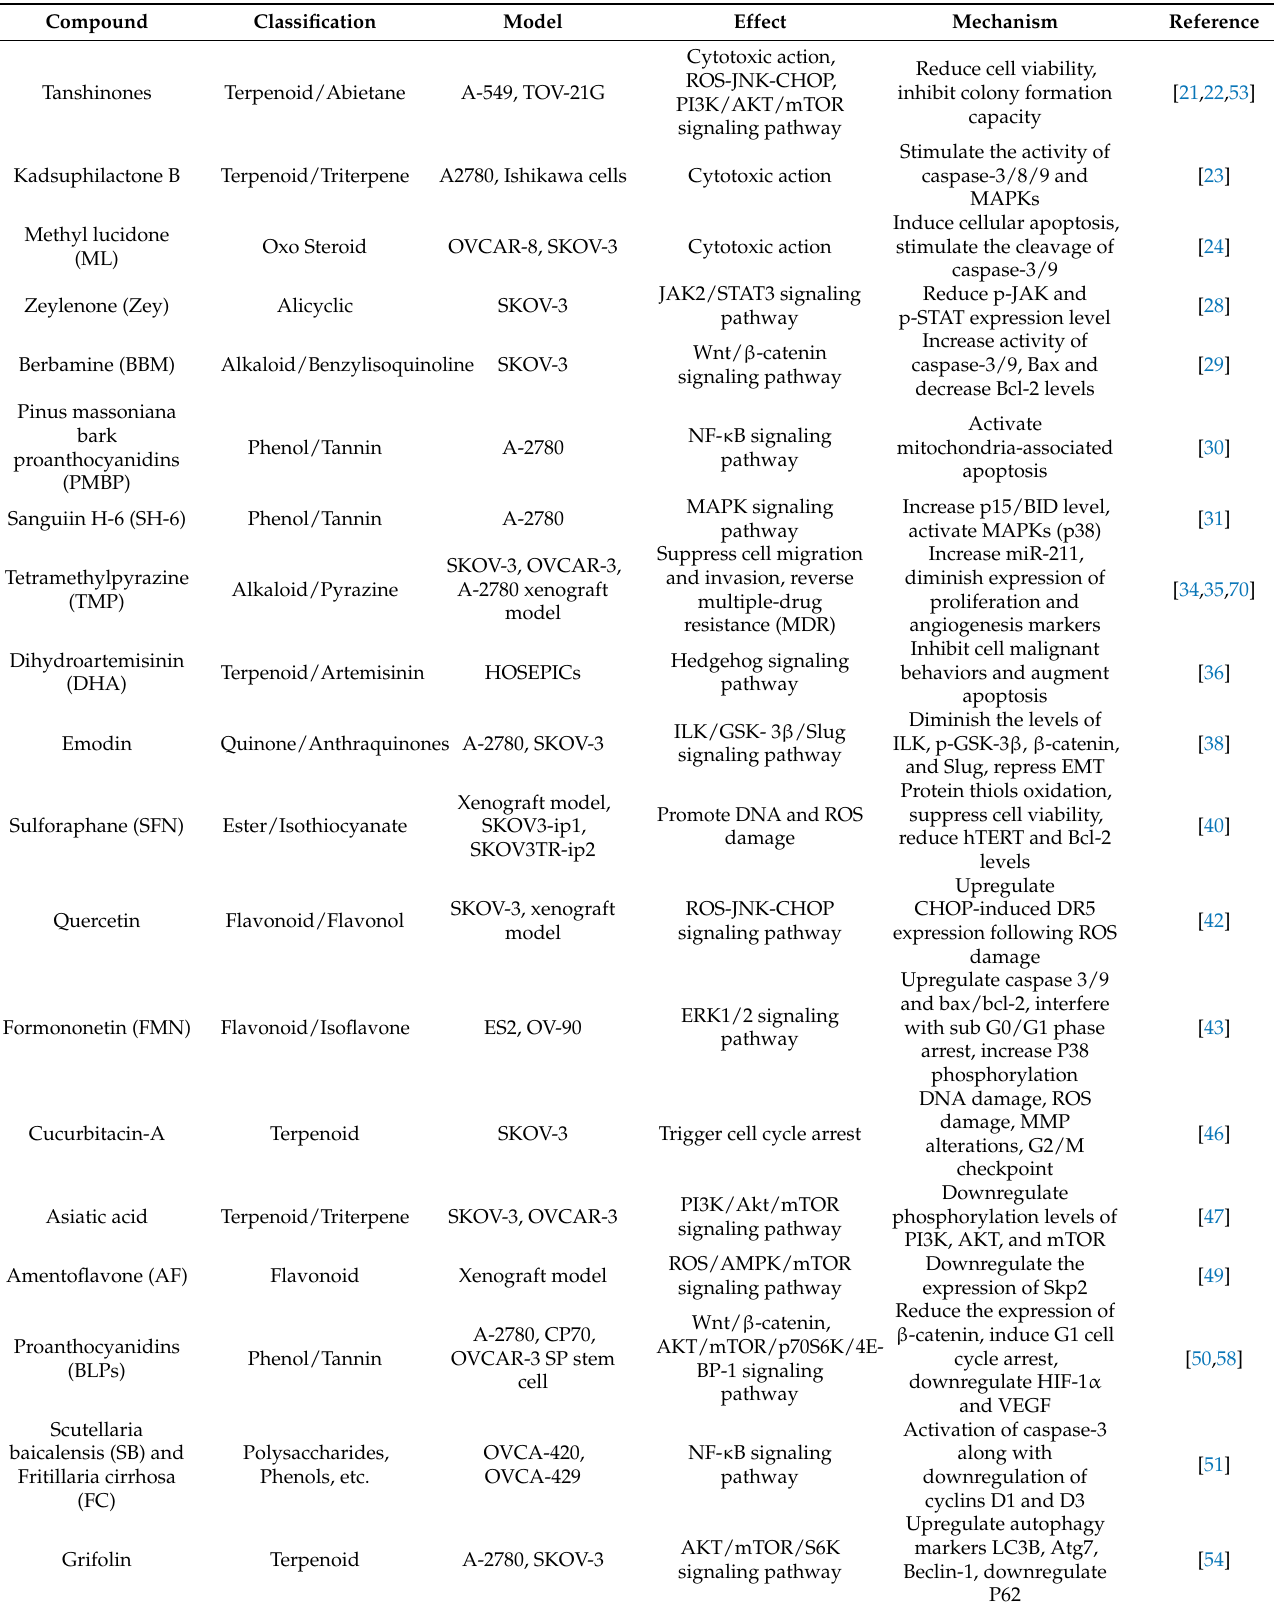
Table 1. The antitumor effects of natural plants components in ovarian